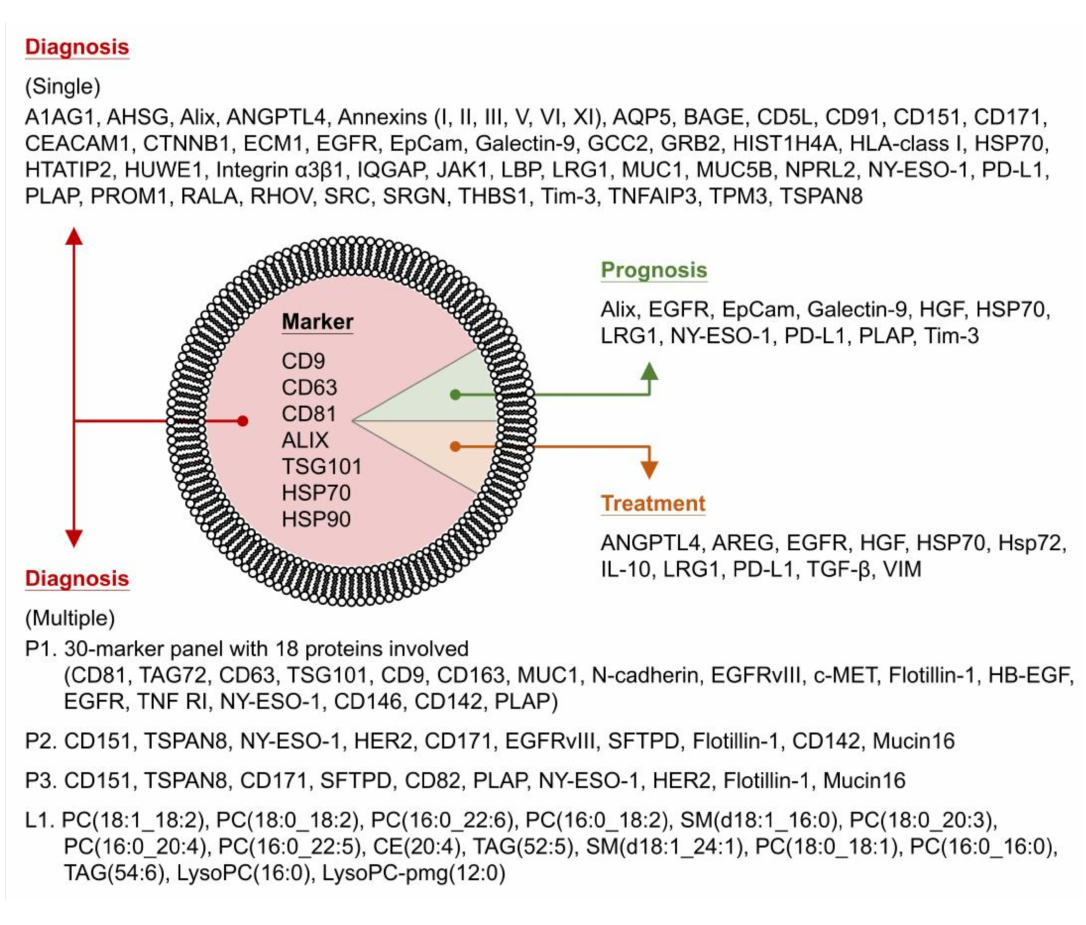
Figure 1. Potential biomarkers for lung cancer diagnosis, prognosis, and treatment. Biomarkers are exosomal proteins and lipids of lung cancer samples. A single marker (A1AG1, AHSG, Alix, ANGPTL4, Annexins (I, II, III, V, VI, XI), AQP5, BAGE, CD5L, CD91, CD151, CD171,